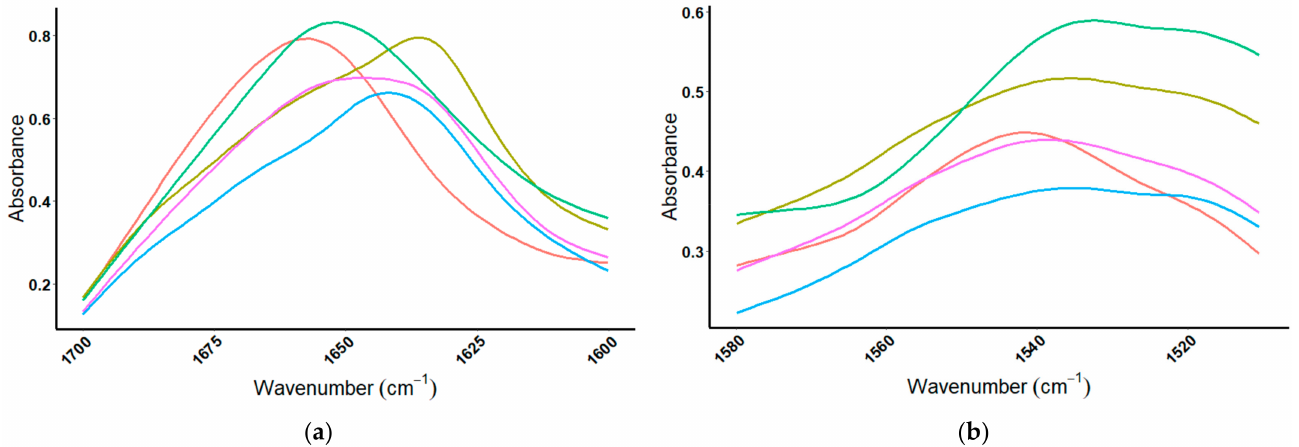
Figure 7. Amide I and amide II regions comparing ISO100 protein powder to protein standards. MIR spectrum of the four whey protein standards ( = β -lactoglobulin, = α -lactalbumin, = BSA, = IgG), and whey protein product = ISO100, in ( a ) the amide I spectral region (1700–1600 cm − 1 ), and ( b ) the amide II spectral region (1580–1510 cm − 1 ).